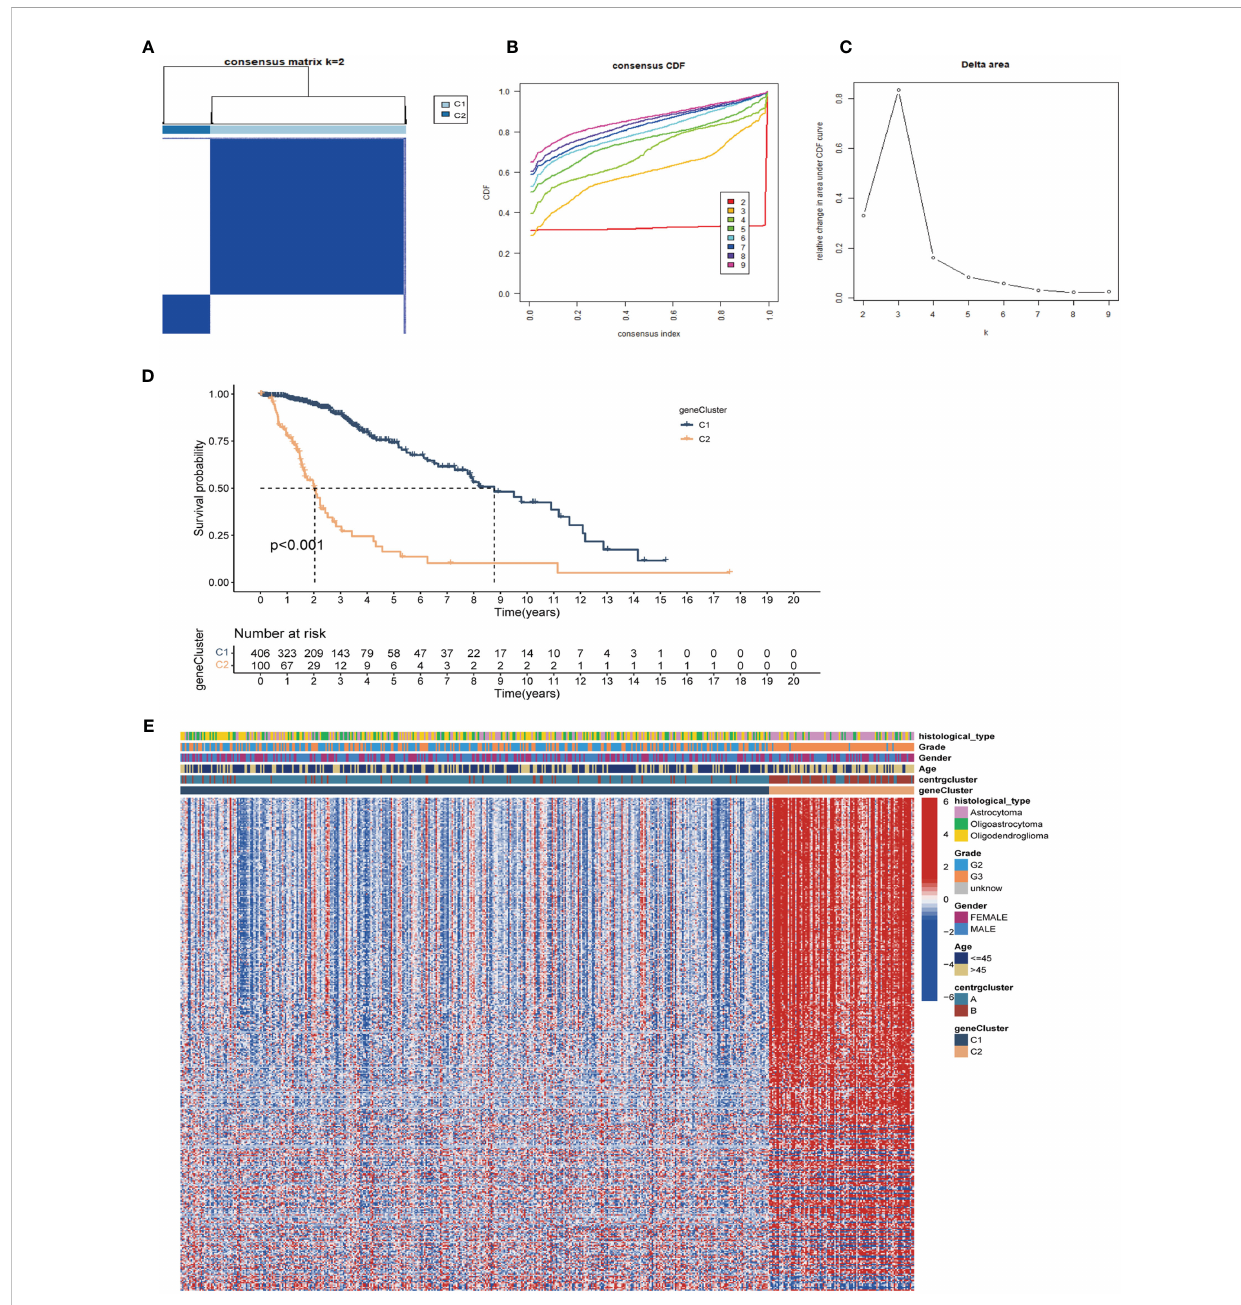
FIGURE 5 Unsupervised clustering analysis based on prognostic DEGs. (A) Consensus clustering divides LGG samples into two gene-subtypes (C1 and C2) base on DEGs (k=2). Detailed of consensus clustering to identi fi cation of DEGs subtypes: cumulative distribution curve (B) and area under the cumulative distribution curve (C) . (D) OS curves of patients in C1 and C2 gene-subtypes. (E) Clinicopathological characteristics and expression of differential genes of C1 and C2. DEGs, differentially expressed